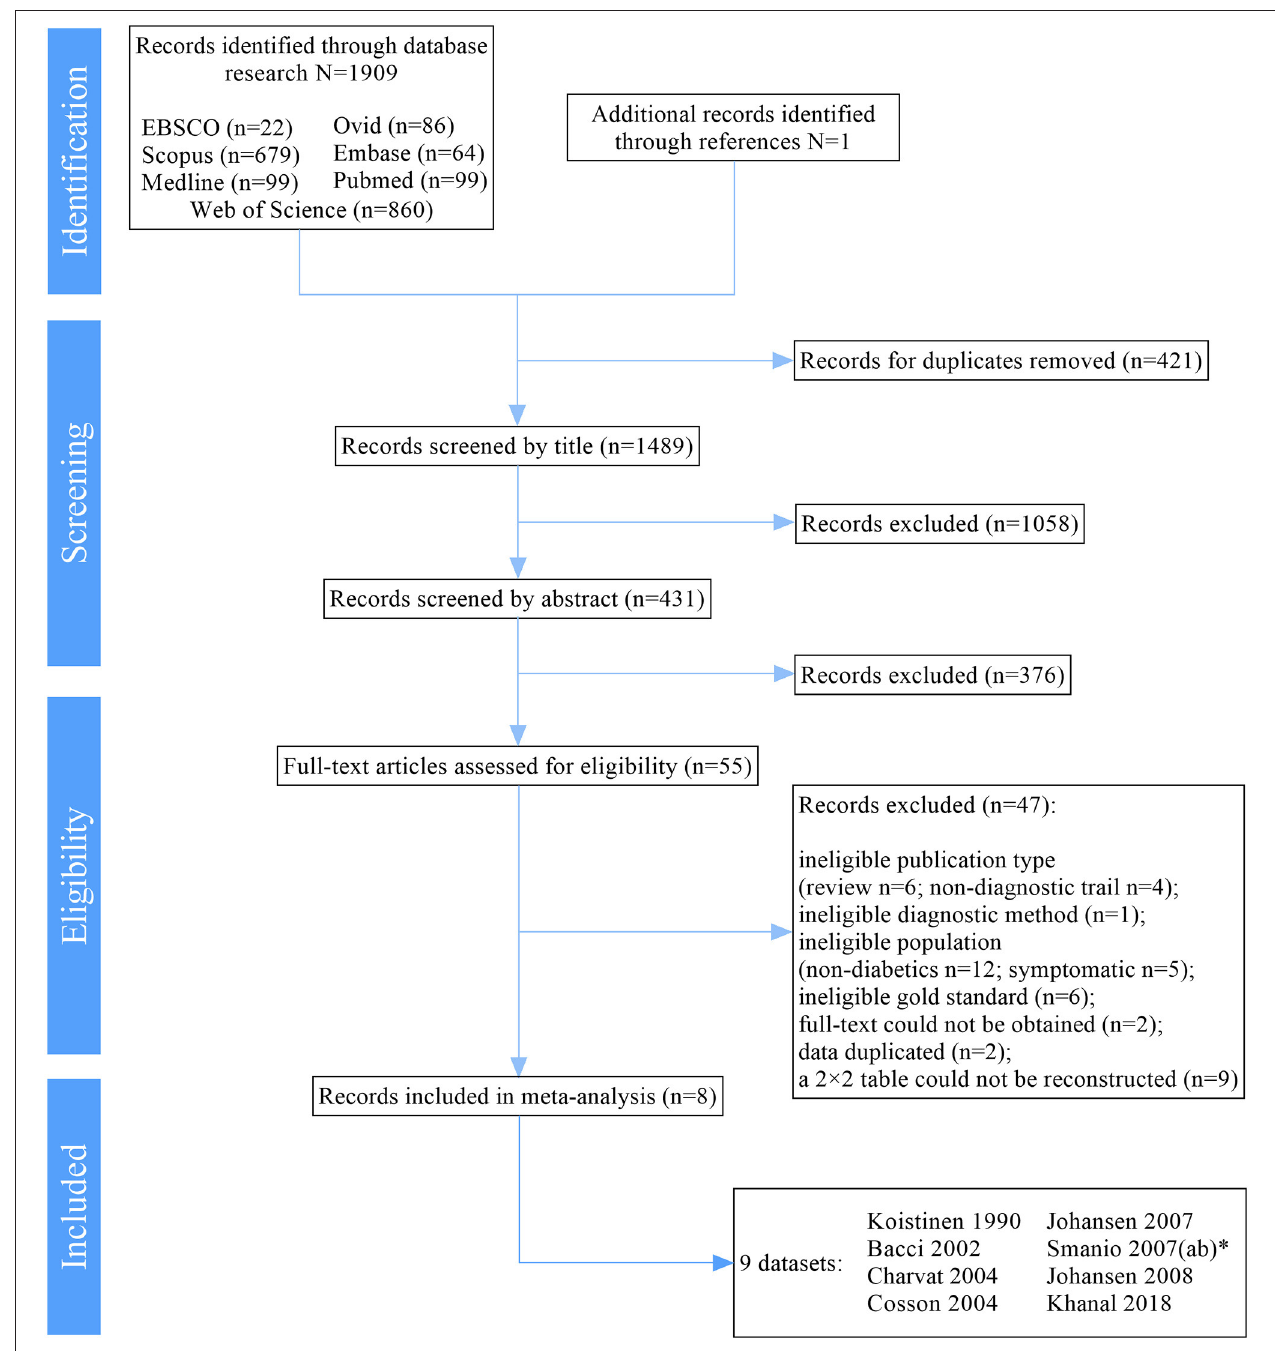
FIGURE 1 | PRISMA Flow Diagram. PRISMA: Preferred Reporting Items for Systematic reviews and Meta-Analysis statement. *ab represents 2 different exercise protocols of EST for detection of CAD in one study (16).